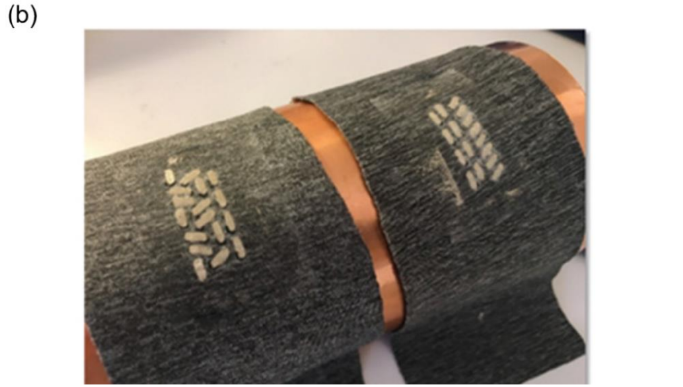
Figure 6. Polymer TEG for human body heat harvesting [135]. ( a ) Fabrication process for textile integrated TEG: 1. Burning holes through the knitted fabric, 2. Filling the holes by stencil printing p- (red) and n-type (blue) materials on both sides of the fabric, 3. Silver interconnects (light blue) are printed onto a heat transfer membrane (light gray) on both sides of the device, 4. Heat pressing interconnects onto both sides of the device using the heat transfer membrane. ( b ) Wearable TEG integrated into knitted fabric consisting of 32 p- and n-type legs. Reproduced with permissions [135]. Copyright 2019 WILEY-VCH Verlag GmbH & Co. KGaA,